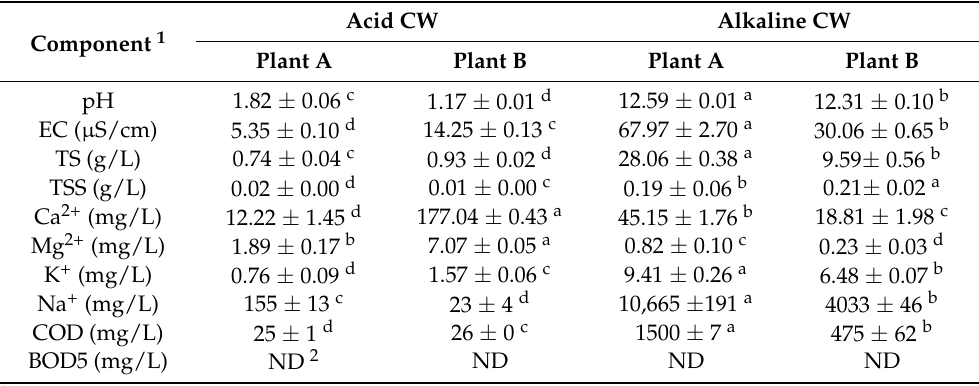
Table 2. Chemical characteristics of cleaning acidic and alkaline wastewater generated after the cleaning of the pasteurizers of two dairy plants (A and